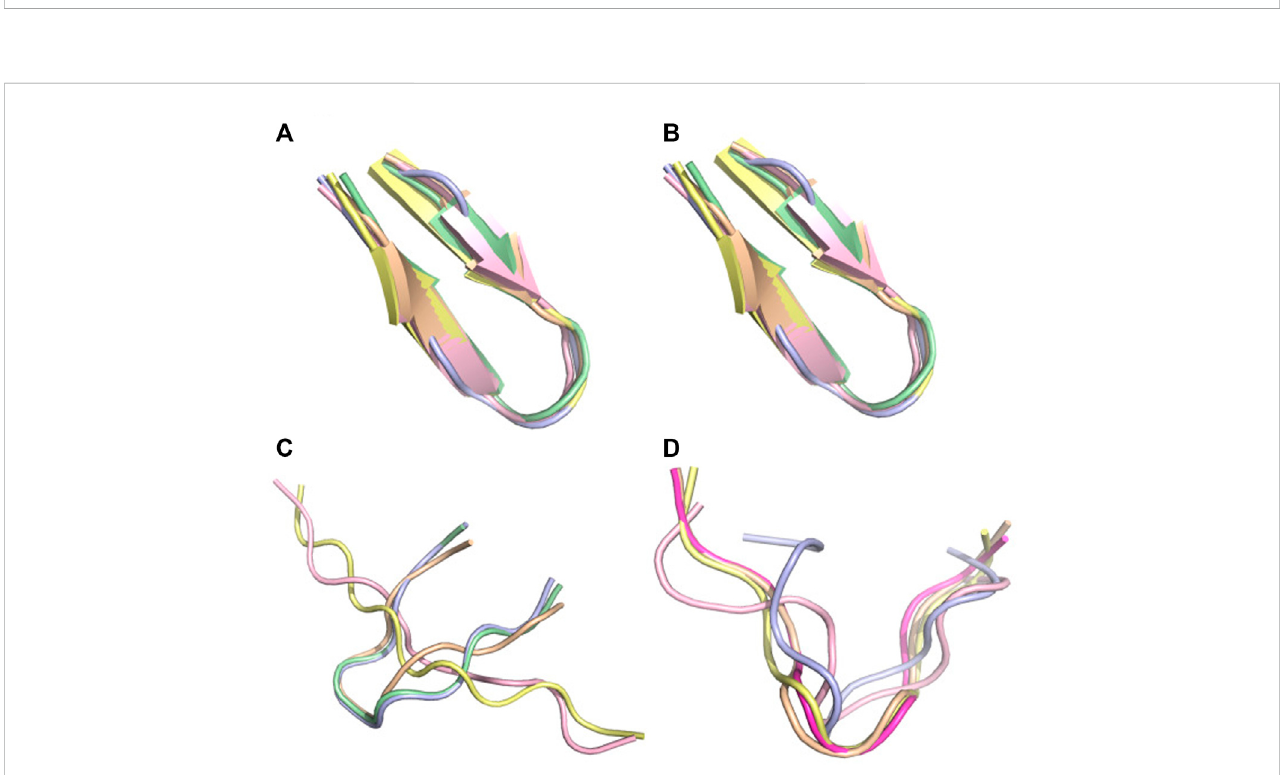
FIGURE 8 Conformational ensemble of pep10. (A) PF-noDH, (B) PF-DH at pH 4.3, (C) AlphaFold2, (D) TrRosetta. For each method, the 5 predicted models are